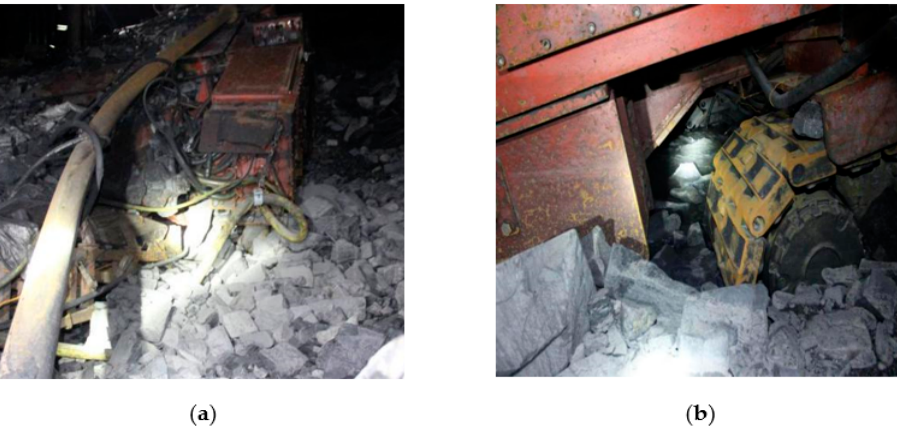
Figure 6. A collapse pit formed at the outlet point. ( a ) Power switches and cables that fell into the collapse pits; ( b ) integrated tunneling machine that fell into the collapse crater.